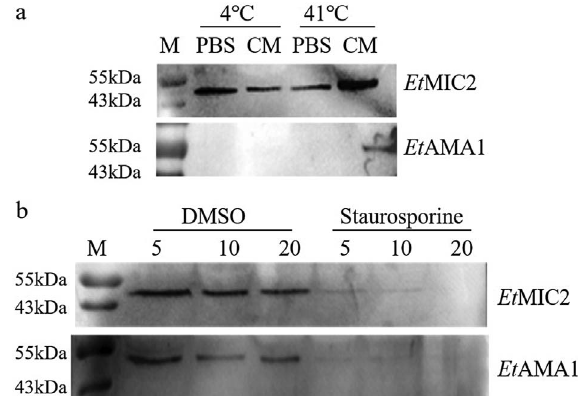
Figure 1. EtAMA1 is secreted by micronemes. (a) EtAMA1 secretion is FCS- and temperature-dependent. Fresh sporozoites were incubated in PBS or complete medium (CM) at 4 (cid:3) C or 41 (cid:3) C for 2 h. Supernatants containing excretory-secretory antigens (ESAs) were harvested and analyzed by western blotting to detect EtAMA1 and EtMIC2. (b) EtAMA1 secretion is inhibited by staurosporine. Sporozoites were incubated in CM with various concentrations of staurosporine or DMSO at 41 (cid:3) C for 2 h. Supernatants containing ESAs was harvested and analyzed by western blotting to detect EtAMA1 and